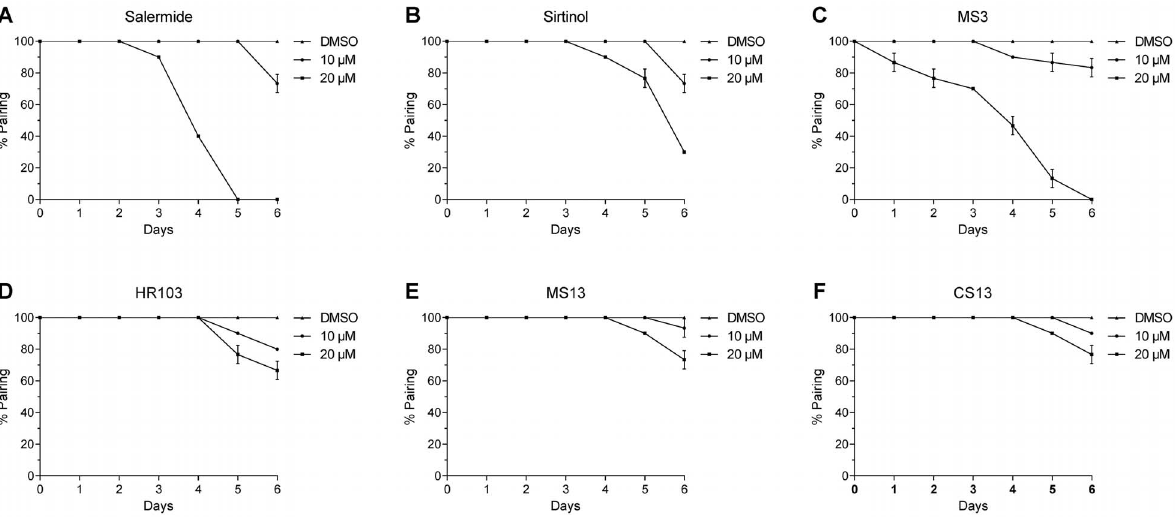
Figure 6. Freshly perfused adult couples were maintained in culture for 6 days and incubated with 10 m M or 20 m M of Salermide (A), Sirtinol (B), MS3 (C), HR103 (D), MS13 (E) and CS13 (F). DMSO solvent was use as the control. Percentages of paired worm were determined daily. The results are expressed as mean % paired worms ( 6 SEM, three independent experiments).